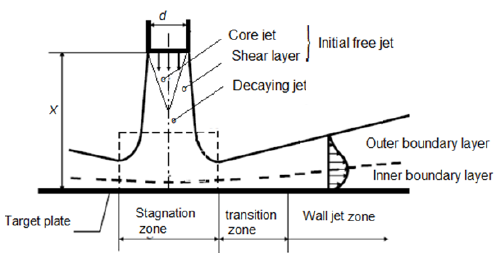
Figure 1. Schematic of flow structure of the jet and the different zones on the target plate